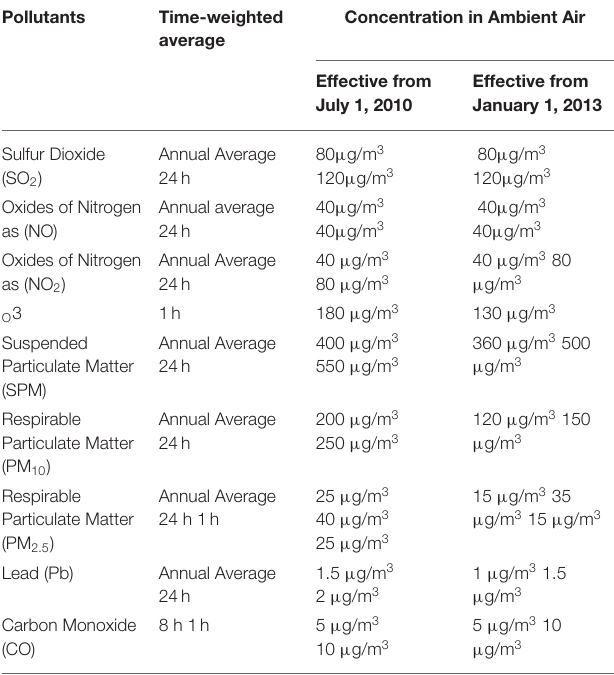
TABLE 2 | National Environmental Quality